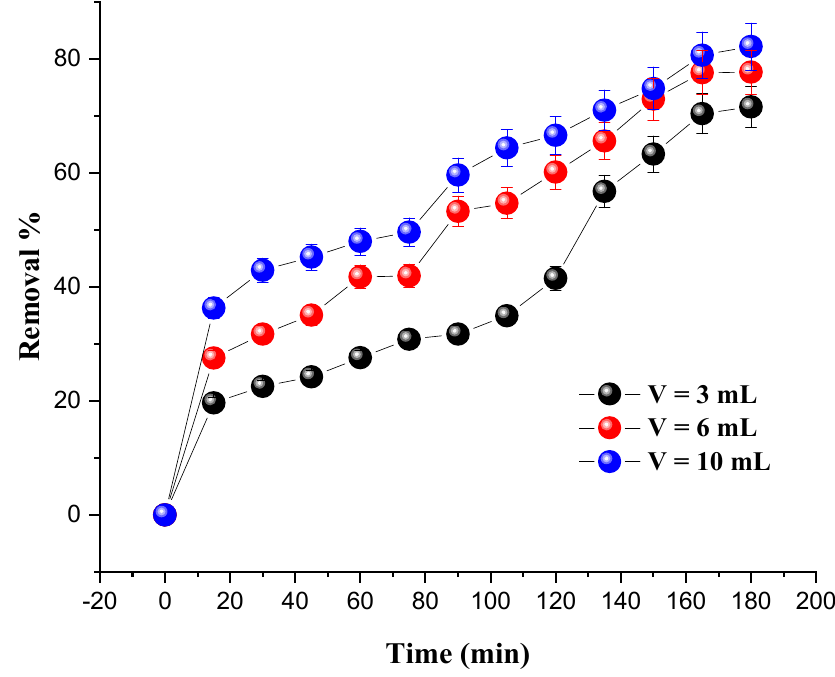
Figure 7. Effect of oxidant volume on MG removal. Reaction conditions: C 0 = 20 mg/L, m = 0.8 g, pH = 7 and T = 25 °C.